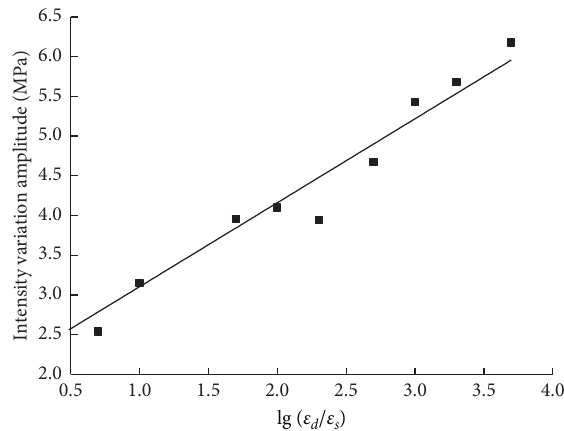
Figure 10: Influence of loading strain rate and size effect on the variation amplitude of the concrete compressive